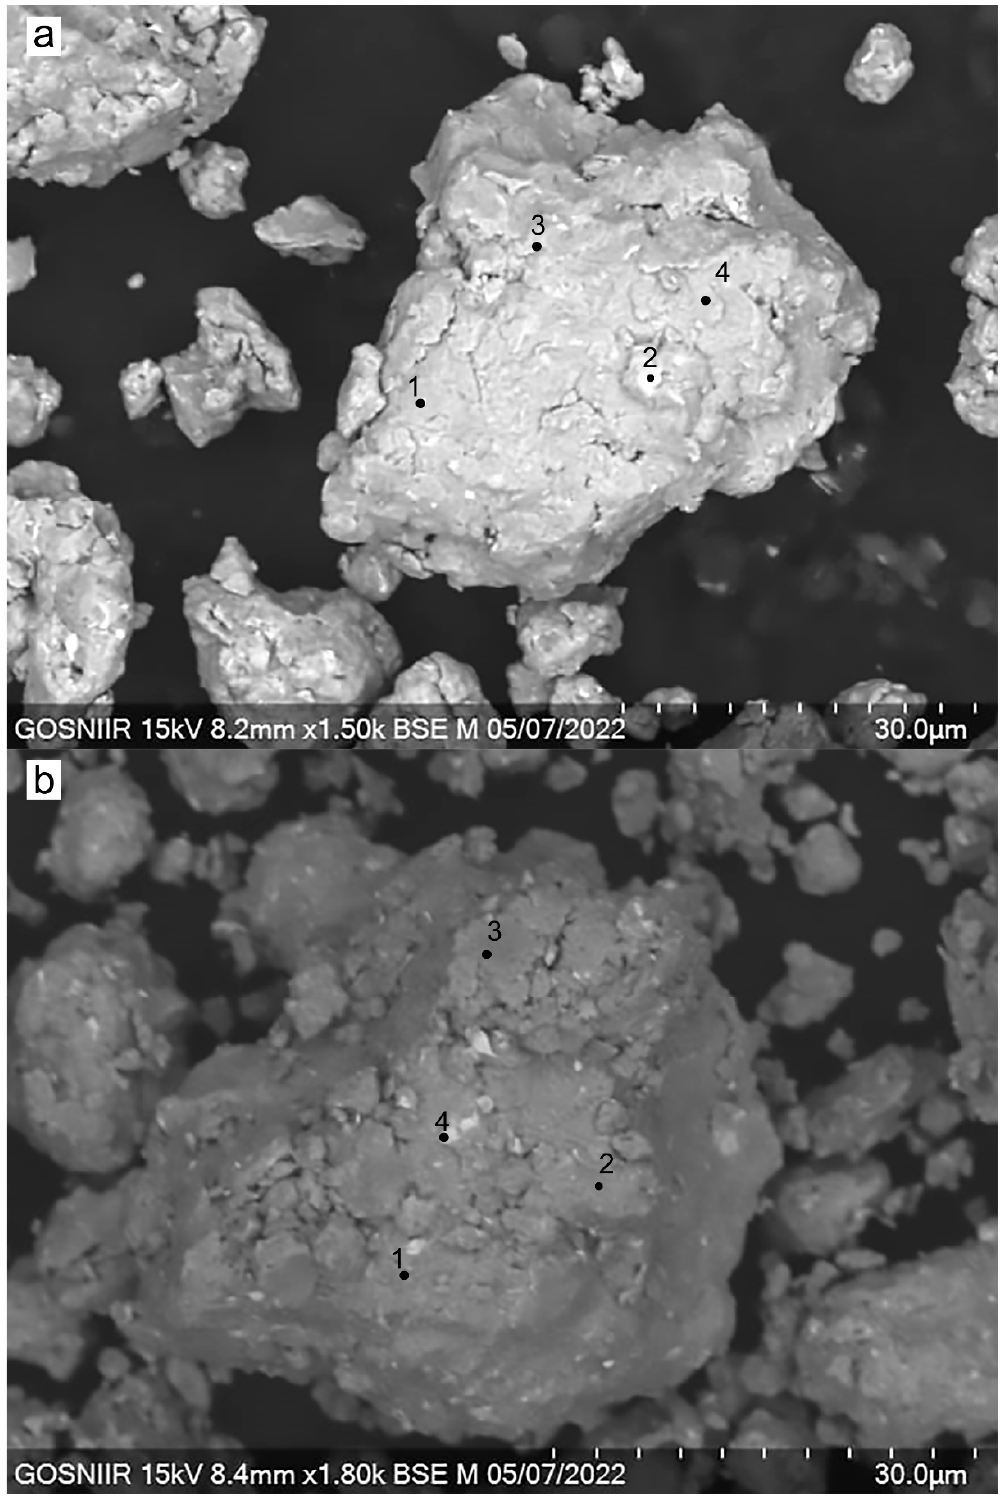
Figure 4. The surface morphology of agglomerates obtained during mechanical alloying after 5